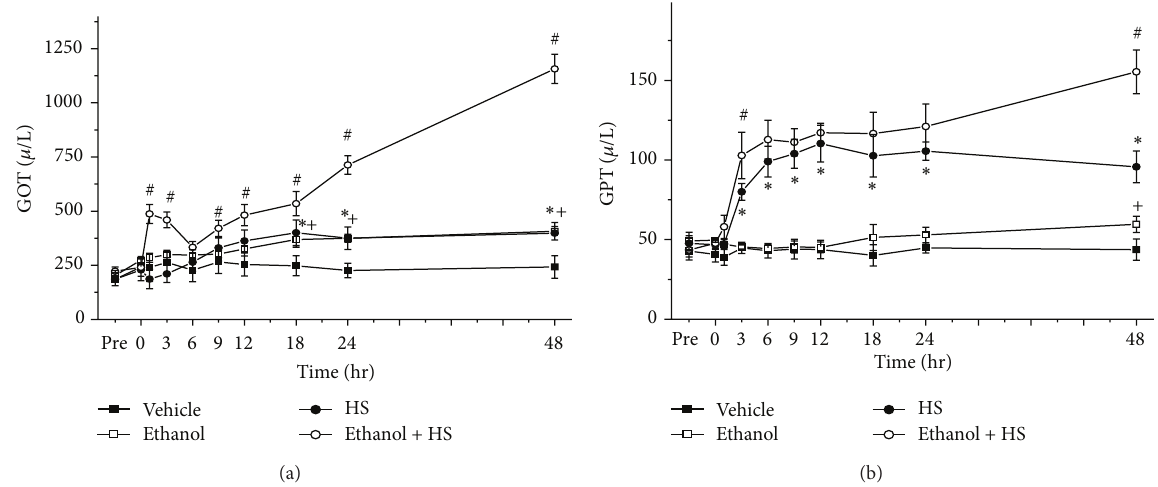
Figure 3: Changes in serum (a) glutamic oxaloacetic transaminase (GOT) and (b) glutamic pyruvic transaminase (GPT) after hemorrhagic shock in rats. ∗ 𝑃 < 0.05 for the HS group compared with the Vehicle group. + 𝑃 < 0.05 for the Ethanol group compared with the Vehicle group. # 𝑃 < 0.05 for the Ethanol + HS group compared with the HS group.